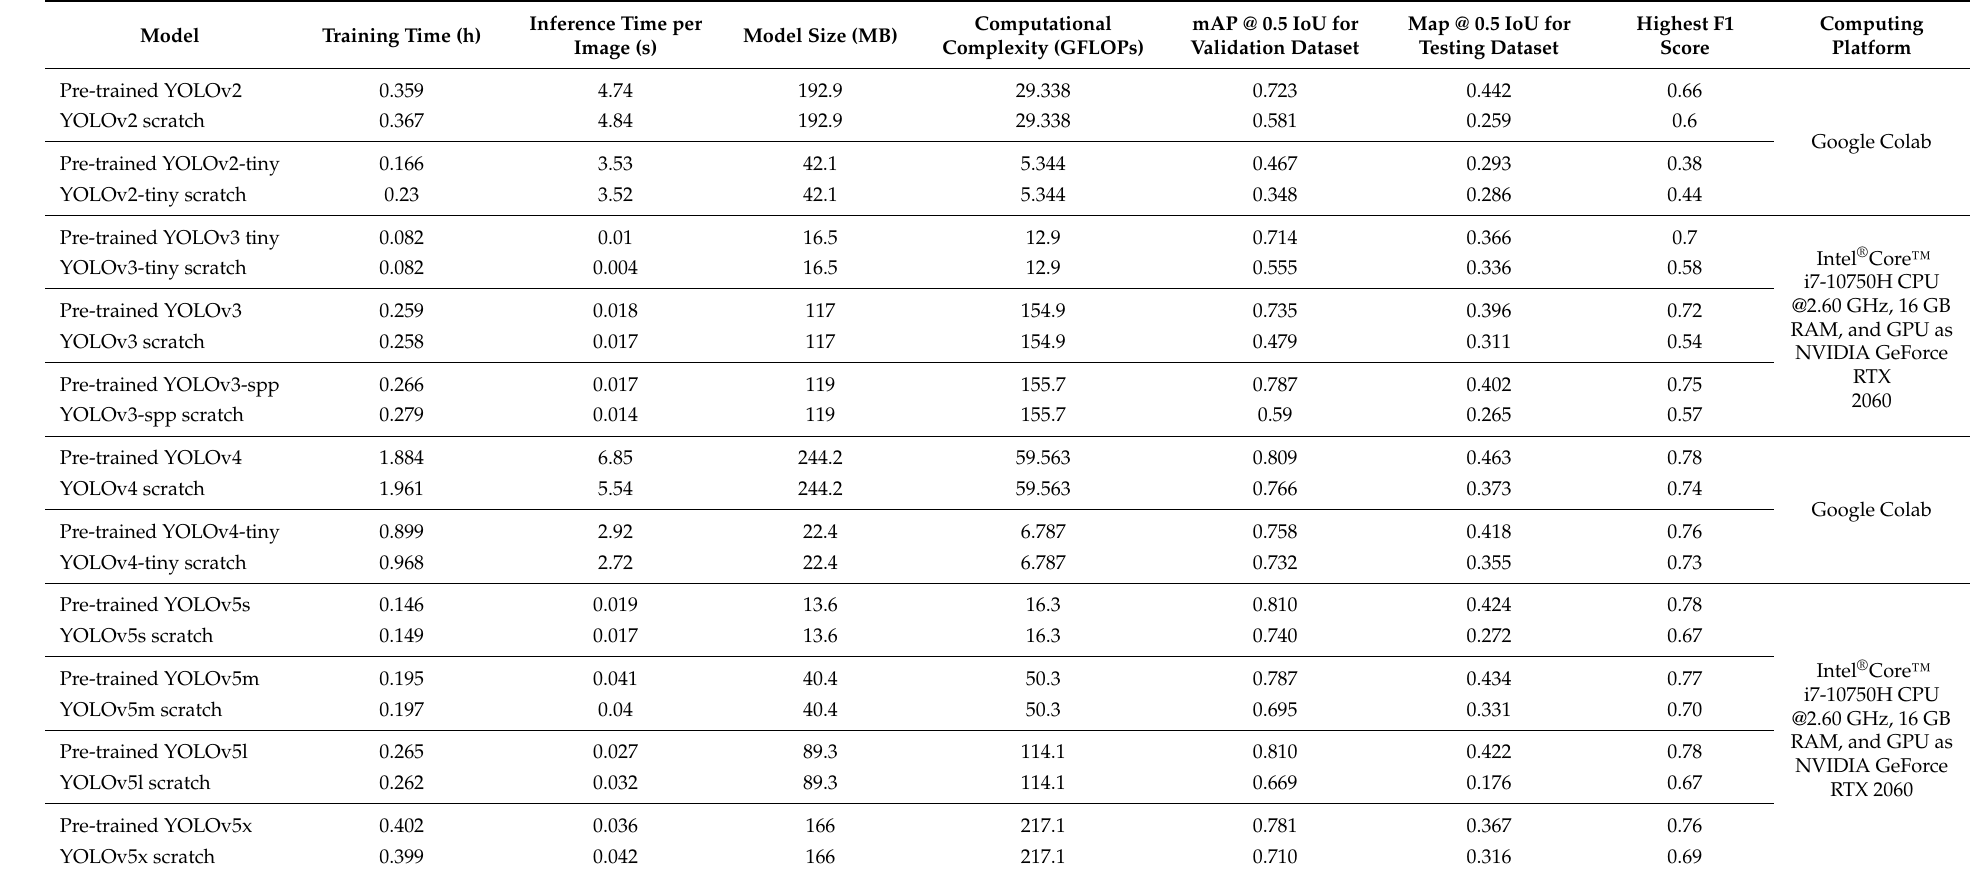
Table 3. Experiment I and II results. Detection Performance on HMH